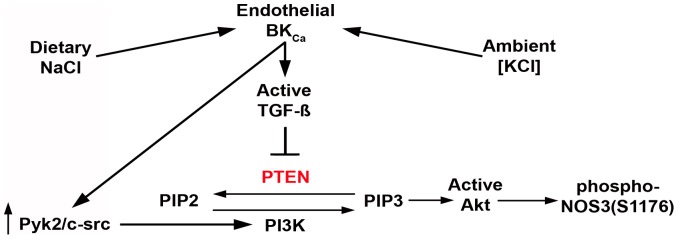
Schematic representation of the findings of the present studies, which focused on PTEN.Prior studies demonstrated that dietary salt intake increased endothelial production of TGF-ß, while potassium mitigated this effect [32], [33], [40], [42], [43], [54]. The published findings further demonstrated an integral role for the endothelial BKCa channel in this process [40]. The present study demonstrated that endothelial PTEN levels are regulated by factors that include dietary salt intake, which increases TGF-ß, and exogenous TGF-ß. The present study further elucidated in detail the mechanism by which ambient potassium levels regulated PTEN levels and Akt activity through TGF-ß. Endothelial PTEN and phospho-NOS3(S1176) levels responded to changes in dietary salt intake in young animals. In young animals, an increase in TGF-ß is associated with increased NOS3 activity and NO production. With aging, however, PTEN levels increased. By 12 months of age, PTEN levels did not change and phospho-NOS3(S1176) did not increase during increased salt intake. The increase in TGF-ß during aging was not associated with a concomitant increase in NO, which has been shown to mitigate endothelial TGF-ß production [43]. The potential consequence of diminished NO production and unopposed TGF-ß production is altered vascular structure and function, particularly in the setting of high salt intake.